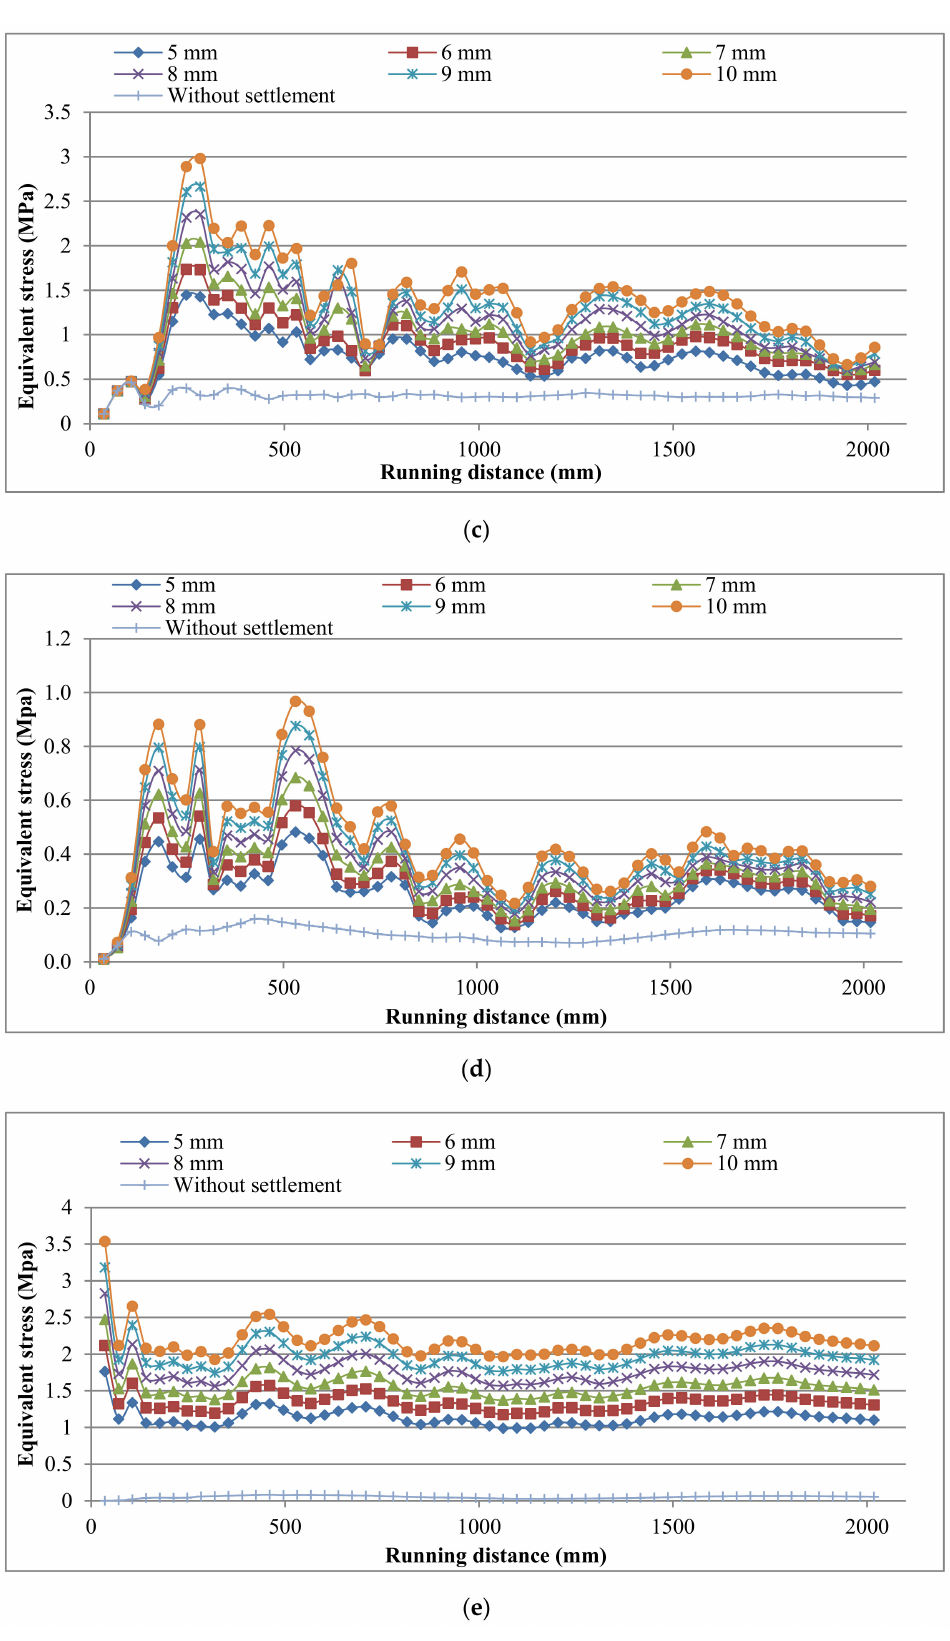
Figure 18. Stresses of the track elements in states with and without settlement: ( a ) railhead; ( b ) the 11th sleeper; ( c ) ballast layer; ( d ) subballast layer; ( e ) subgrade